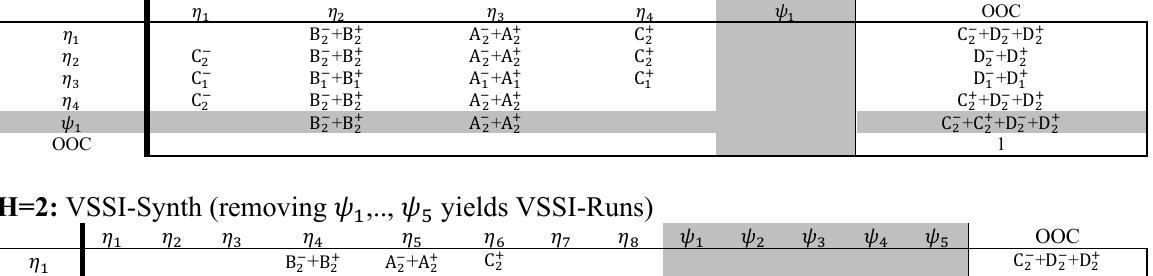
TPMs of the VSSI-Synth and VSSI-Runs schemes when H ∈ {1,2} H=1: VSSI-Synth (removing 𝜓 yields VSSI-Runs) (cid:2869)